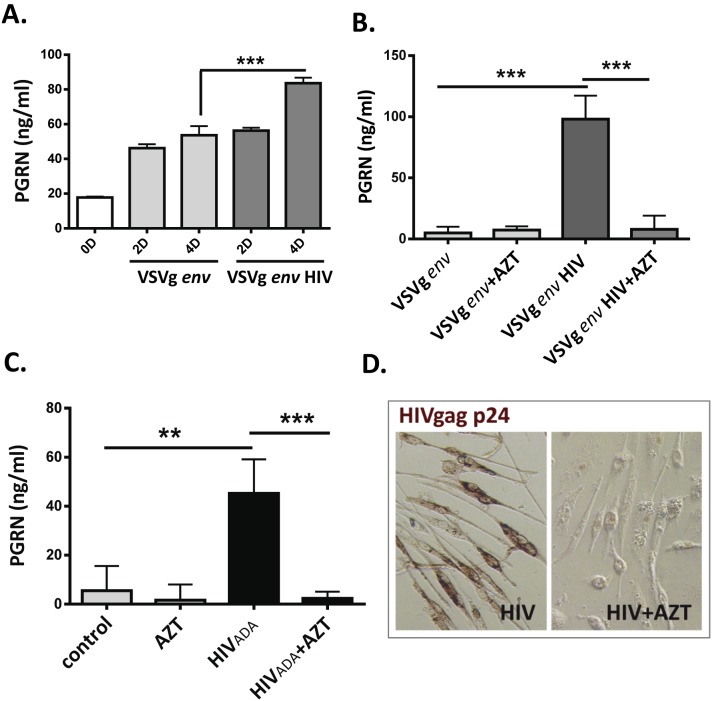
HIV infection induces PGRN production in microglia.Primary human microglial cells were inoculated with VSVg env HIV or HIVADA and PGRN in culture supernatants were determined by ELISA as described in the Materials and Methods. Control cultures were treated with VSVg env protein or mock infected. (A) Results with VSVg env HIV are shown. Culture supernatants were collected at 2 D and 4 D with complete change of medium (mean ± SD from triplicate cultures) (B) Microglia were incubated with AZT (10 µg/ml) or vehicle for 1 h, then exposed to VSVg env HIV as in A. PGRN was measured at 7 D and 14 D with complete change of medium. Data shown are accumulation between 7D–14D (mean ± SD, n = 3). (C) HIVADA (HIV env bearing virus) was used to determine PGRN production as described in the Materials and Methods. Data shown are PGRN accumulation in culture supernatants between 7D–14D (mean ± SD, n = 3) (D) Microglial cultures infected with VSVg env HIV in B showing cell viability, gag p24 expression, and complete suppression of p24 by AZT treatment. **P<0.01, ***P<0.001 by ANOVA followed by Bonferroni correction.